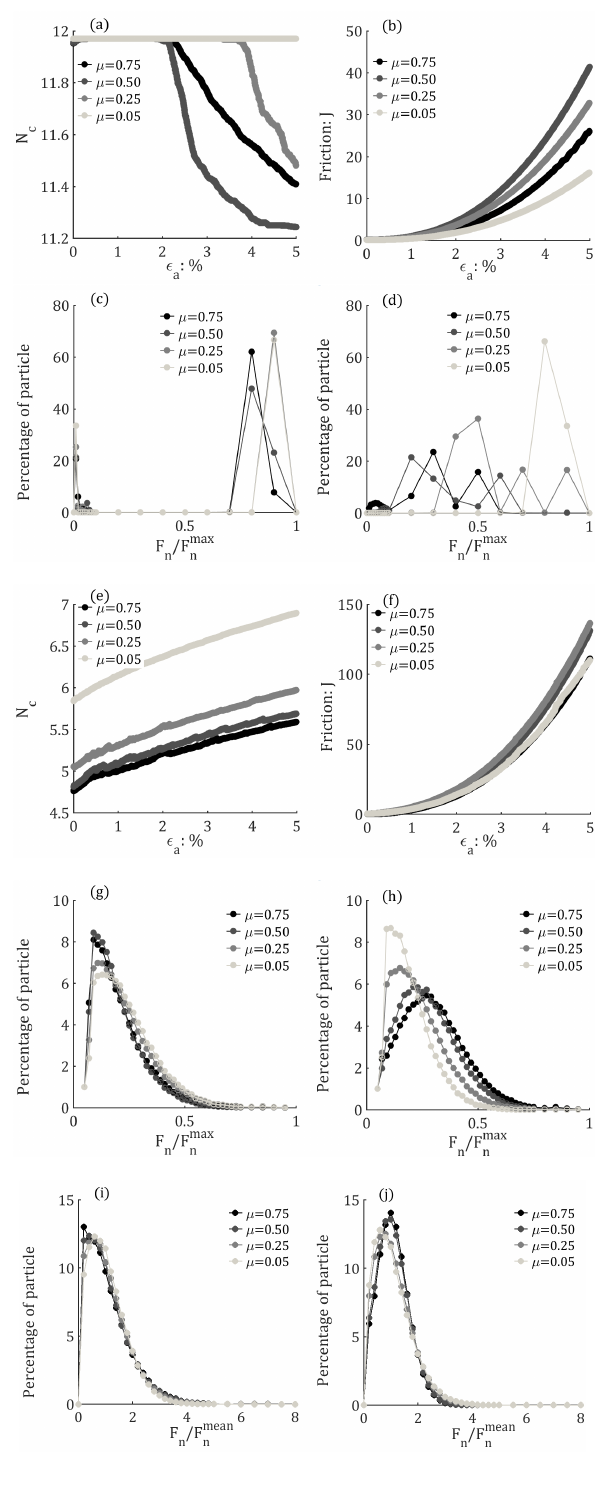
Figure 8. Evolutions of the coordination number and friction